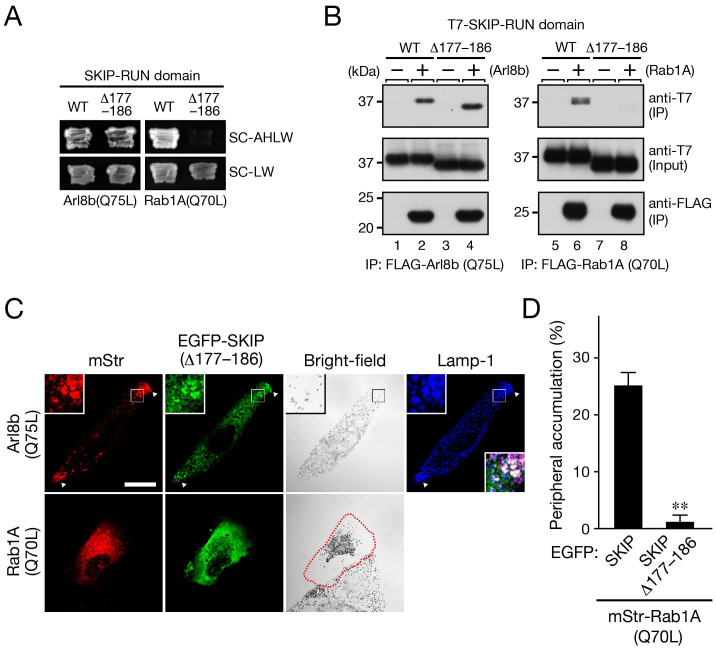
The Rab1A–SKIP interaction is necessary for anterograde melanosome transport.(A) Interaction between SKIP-RUN (wild-type or Δ177–186) and Arl8b or Rab1A as revealed by yeast two-hybrid assays. Yeast cells containing pGBD-C1-Arl8b(Q75L)ΔΝ or pGBD-C1-Rab1A(Q70L)ΔCys and pAct2-SKIP-RUN (wild-type or Δ177–186) were streaked on SC-AHLW and incubated at 30°C for 1 week. (B) Interaction between SKIP-RUN (wild-type or Δ177–186) and Arl8b or Rab1A as revealed by coimmunoprecipitation assays. Beads coupled with either FLAG-Arl8b(Q75L) (lanes 1–4) or FLAG-Rab1A(Q70L) (lanes 5–8) were incubated with COS-7 cell lysates containing T7-SKIP-RUN (lanes 1, 2, 5, and 6) or T7-SKIP(Δ177–186)-RUN (lanes 3, 4, 7, and 8), and the proteins bound to the beads were analyzed by immunoblotting with the antibodies indicated. (C) Typical images of melan-a cells expressing EGFP-SKIP(Δ177–186) together with Arl8b(Q75L)-mStr (top row), or mStr-Rab1A(Q70L) (bottom row) are shown (the lysosomal marker Lamp-1 images and their corresponding bright-field images). Cells exhibiting perinuclear melanosome aggregation are outlined with a broken line. The insets show magnified views of the boxed areas. The arrowheads point to the site of lysosome accumulation at the cell periphery. Note that melan-a cells expressing EGFP-SKIP(Δ177–186) together with mStr-Rab1A(Q70L) no longer exhibited peripheral melanosome accumulation (bottom row), whereas cells expressing Arl8b(Q75L)-mStr (top row) still exhibited peripheral lysosome accumulation. Scale bars, 20 μm. (D) The results are expressed as the percentages of transfected cells that exhibited peripheral melanosome accumulation, and the bars represent the means and S.E. of the data from three independent experiments (n >50). **, p <0.01 in comparison with the cells expressing both mStr-Rab1A(Q70L) and EGFP-SKIP (Student's unpaired t test).